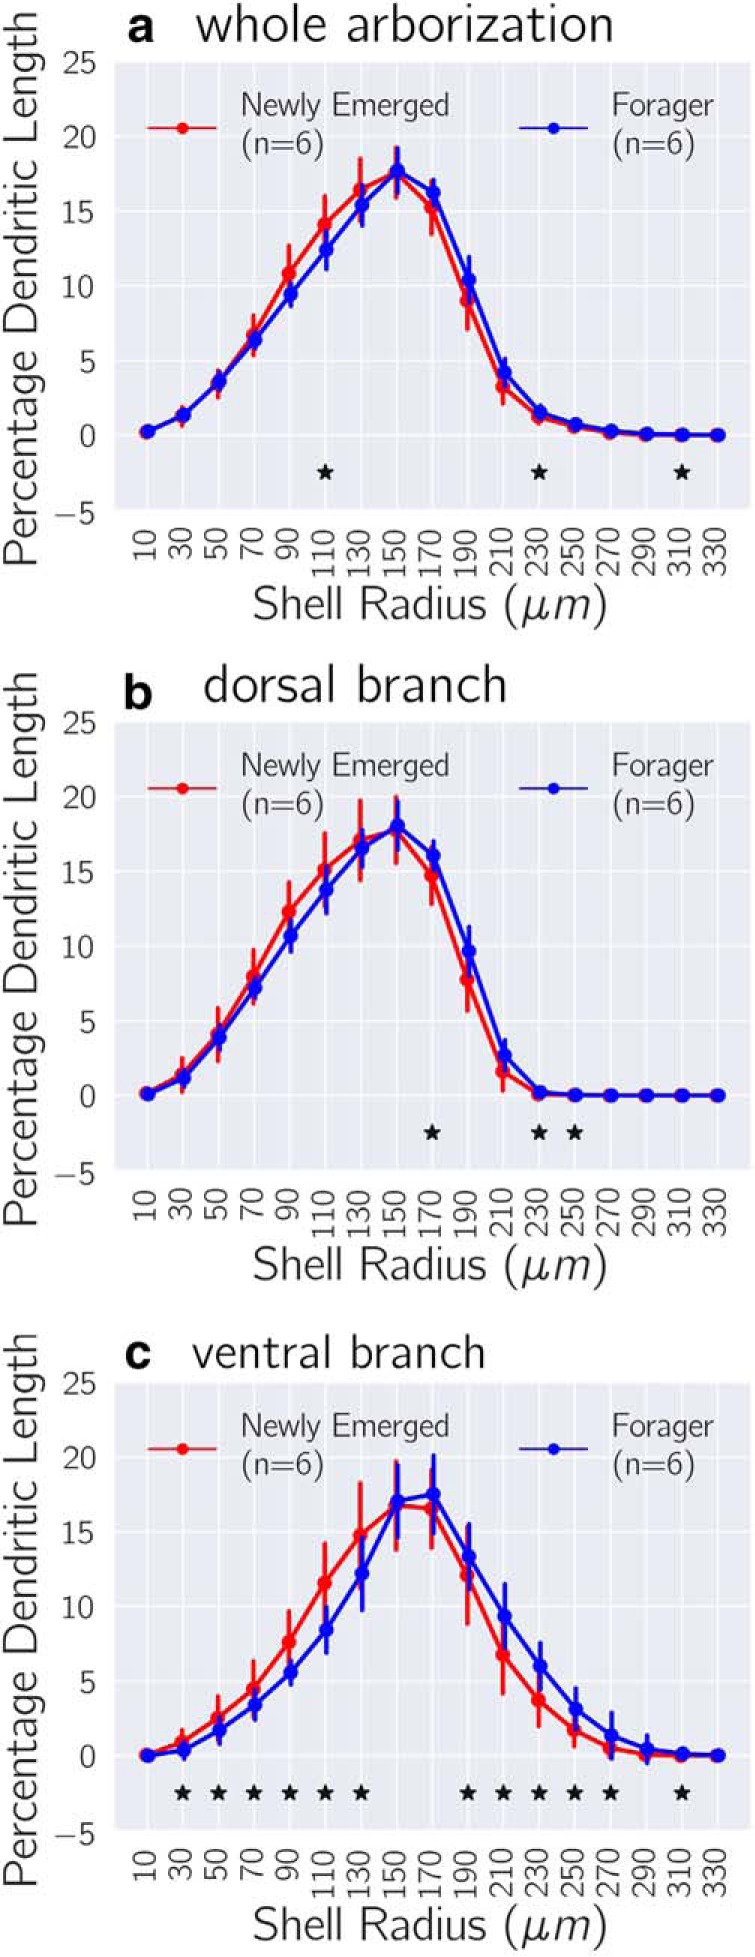
Changes in radial distribution of dendritic density. Comparison of PDLshell calculated for dendrites contained in concentric spherical shells of thickness 20 μm for the WA, DB, and VB, respectively, in a, b, and c. Solid circles indicate means and error bars indicate SD, both of which were calculated by pooling PDLshell values across registration parameters (Extended data Figure 2-1). Asterisks indicate a significant difference in PDLshell between maturation levels independent of registration parameters (see Extended data Figure 2-1). ART two-way ANOVA was used for factor analysis with a p value cutoff of 5%. These comparisons indicate a redistribution of dendritic length during maturation, with reductions in proximal parts and increases in distal parts of DL-Int-1 morphologies.